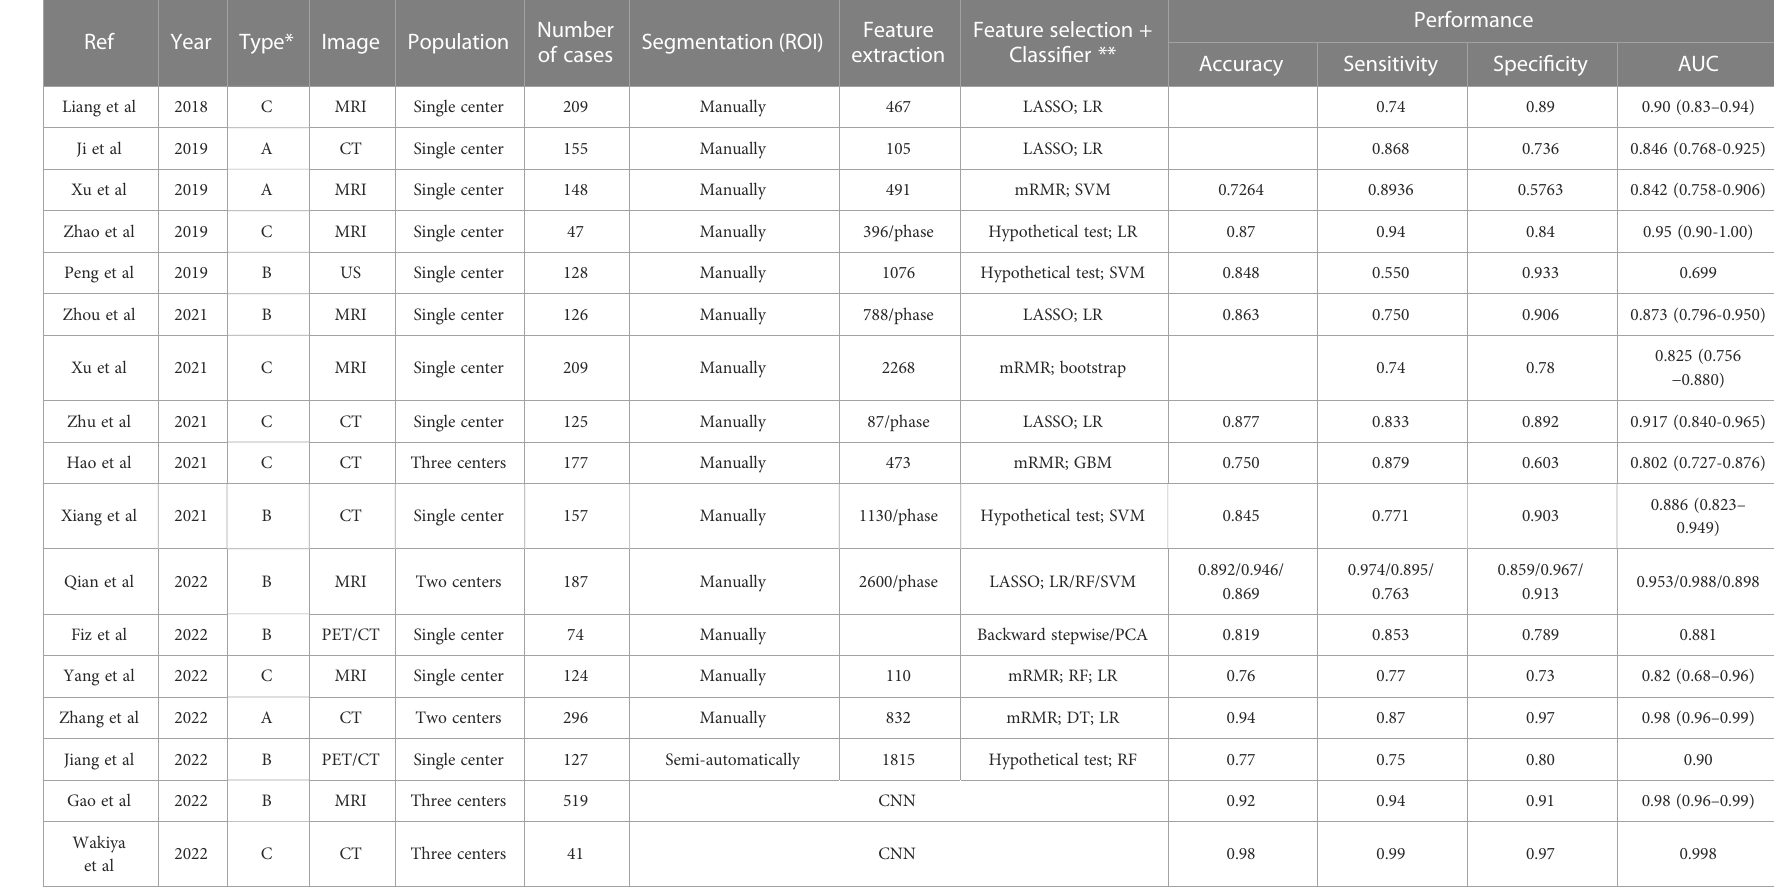
TABLE 1 Application of radiomics in predicting lymph node metastasis, microvascular invasion, and early